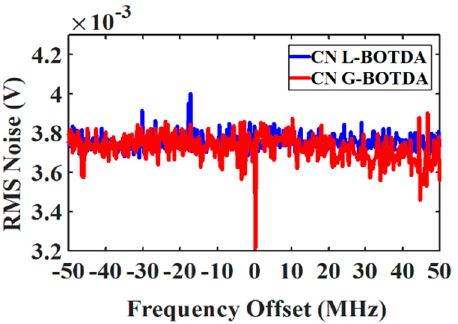
Figure 5. Experimental measurement of the classical noise (CN) with frequency detuning for G-BOTDA (red) and L-BOTDA (blue).